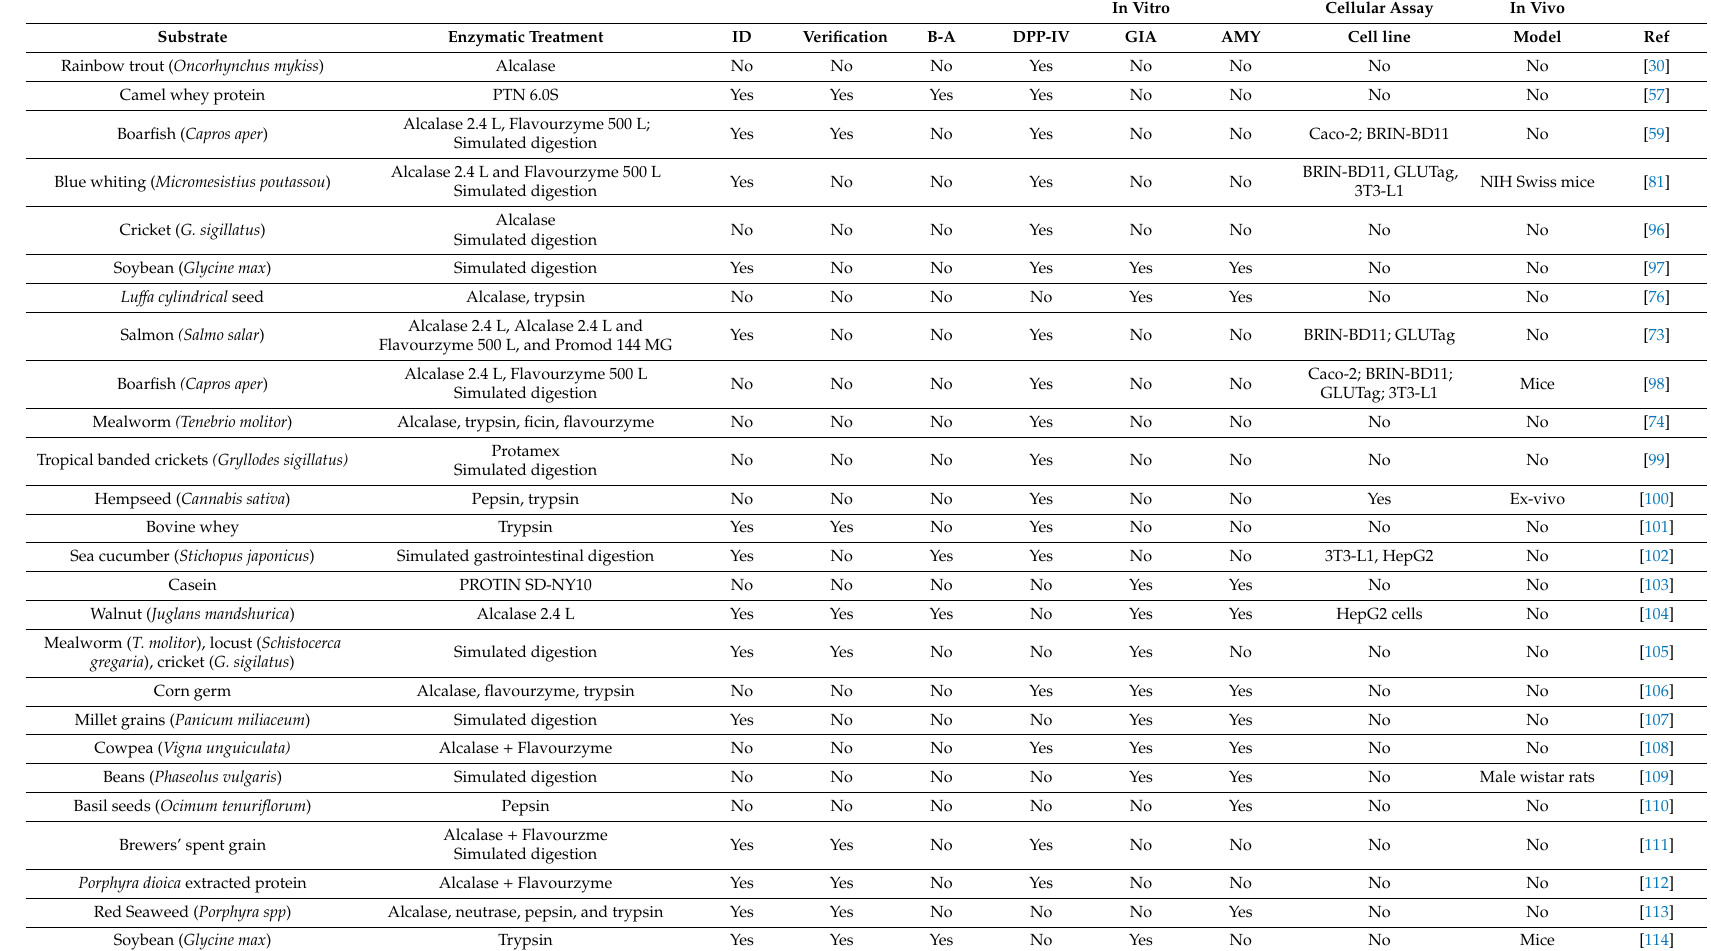
Table 2. Summary of recent publications concerning antidiabetic bioactive peptides (from Scopus,